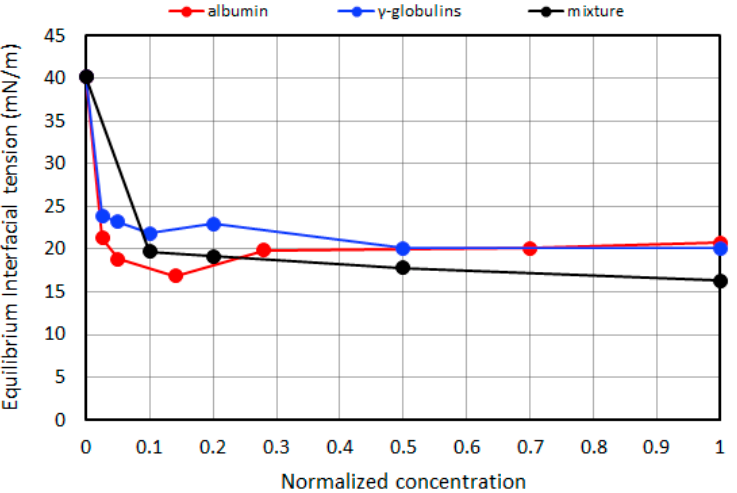
Figure 6. The equilibrium IFT as a function of the protein concentration, expressed as a fraction of the physiological content in the blood; adapted from Nepita et al. [65].